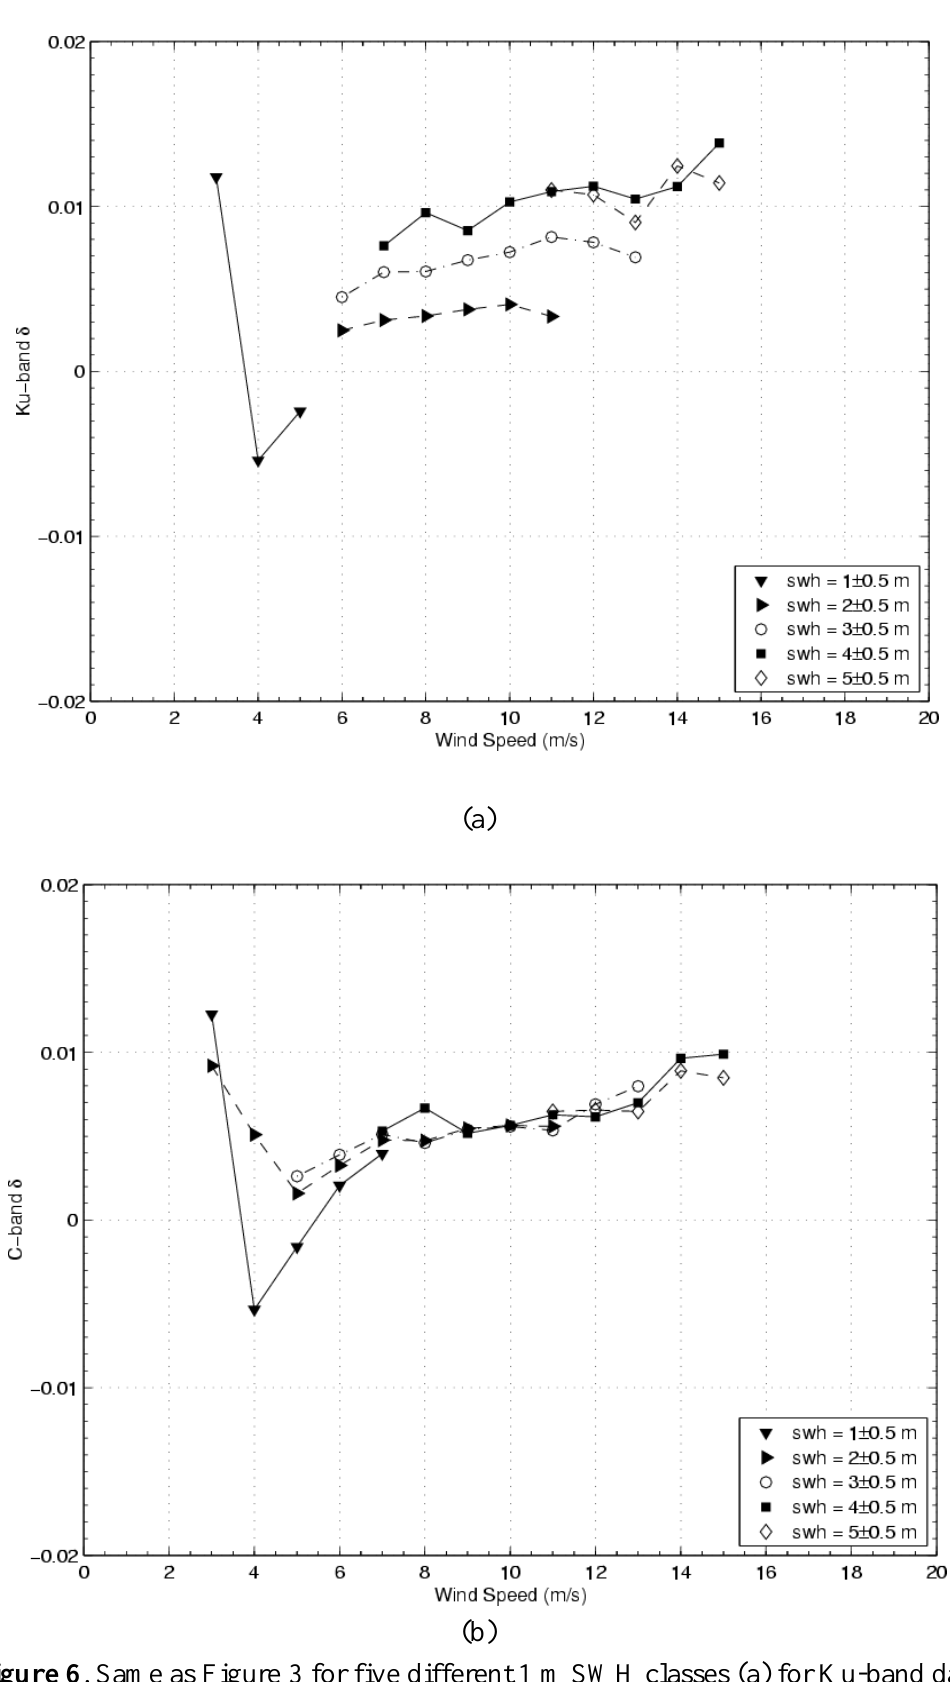
Figure 6 . Same as Figure 3 for five different 1 m SWH classes (a) for Ku-band data and (b) for C-band